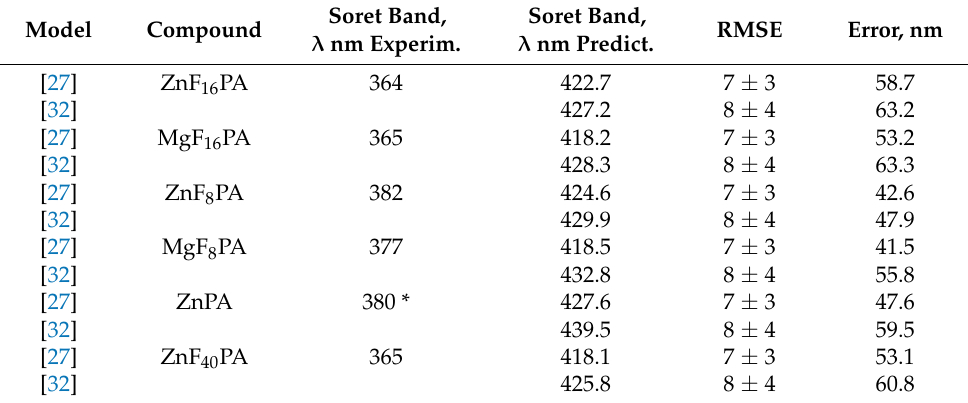
Table 4. Prediction results.